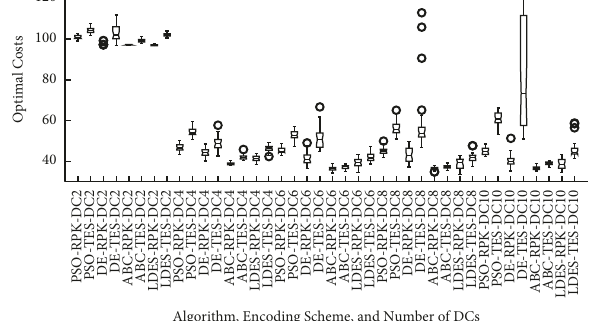
Figure 9: Boxplots of the performance statistics for different combinations of algorithms, encoding schemes, number of DCs, and number of